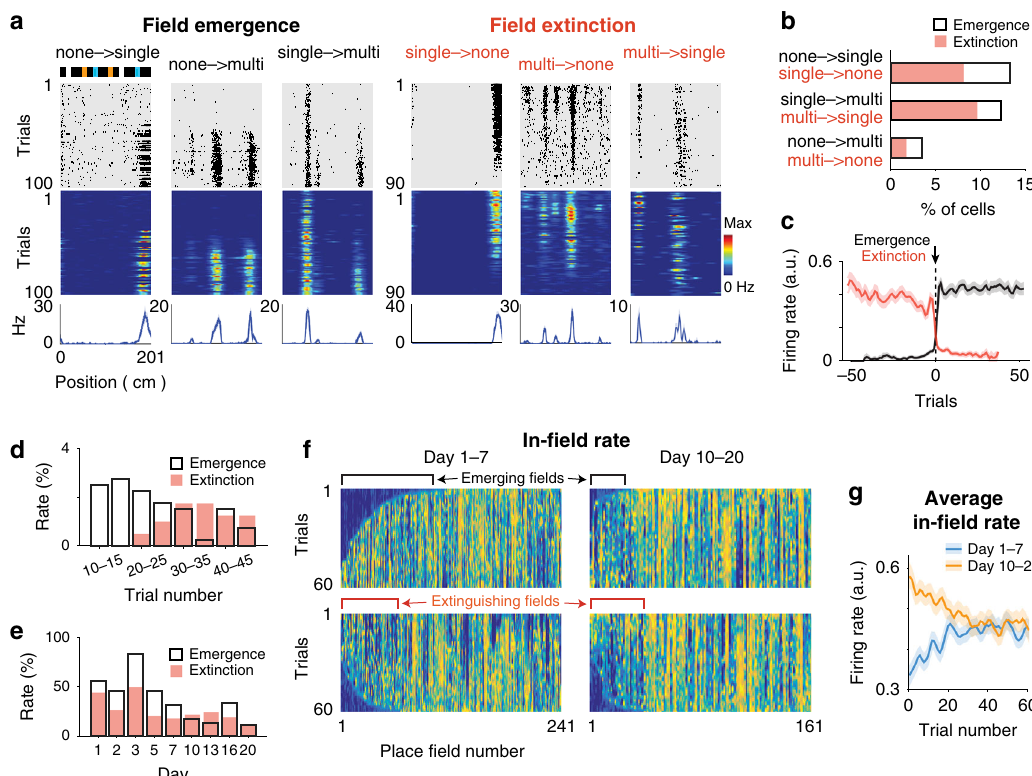
Fig. 4 Emergence and extinction of fi ring fi elds within sessions. a Individual cell examples for fi eld emergences and fi eld extinctions within a session for GCs converting between no fi eld, single- fi eld and multiple- fi eld conditions. Top, scheme of the belt; middle, spike raster plot and color-coded fi ring rate map; bottom, mean fi ring rate. b Proportion of GC conversion types for fi eld emergences (black, n = 41 cells) and fi eld extinctions (salmon, n = 21 cells). Proportions are relative to the number of GCs with place fi elds. c Average in- fi eld fi ring rate (lines, the mean; shadow, s.e.m) for fi eld emergences (black, n = 125 cells) and fi eld extinctions (salmon, n = 88 cells), after aligning to emergence (or extinction) trials of in- fi eld fi ring rate vectors. Note that fi eld emergence is relatively instantaneous, as the in- fi eld fi ring rate reaches an immediate plateau, while fi eld extinction is preceded by a gradual decrease in the in- fi eld fi ring rate. d Proportion of fi eld emergence (black, n = 53 cells) and fi eld extinction (salmon, n = 30 cells) events as a function of session trials. e Proportion of fi eld emergence (black, n = 125 cells) and fi eld extinction (salmon, n = 88 cells) events as a function of days. f Color-coded representation of in- fi eld fi ring rate vectors for all place fi elds on days 1 – 7 (left) and days 10 – 20 (right). In- fi eld fi ring rate vectors are sorted to emphasize fi eld emergences (upper, sorted by trial number for which cumulative sums >20% of vector integrals) and fi eld extinctions (lower, using the same sorting method in the reversed direction). The color scale is the same as that used in ( a ). g Average in- fi eld fi ring rate (lines, the mean; shadow, s.e.m) over trials for days 1 – 7 (blue, n = 241 place fi elds) and days 10 – 20 (yellow, n = 161 place fi